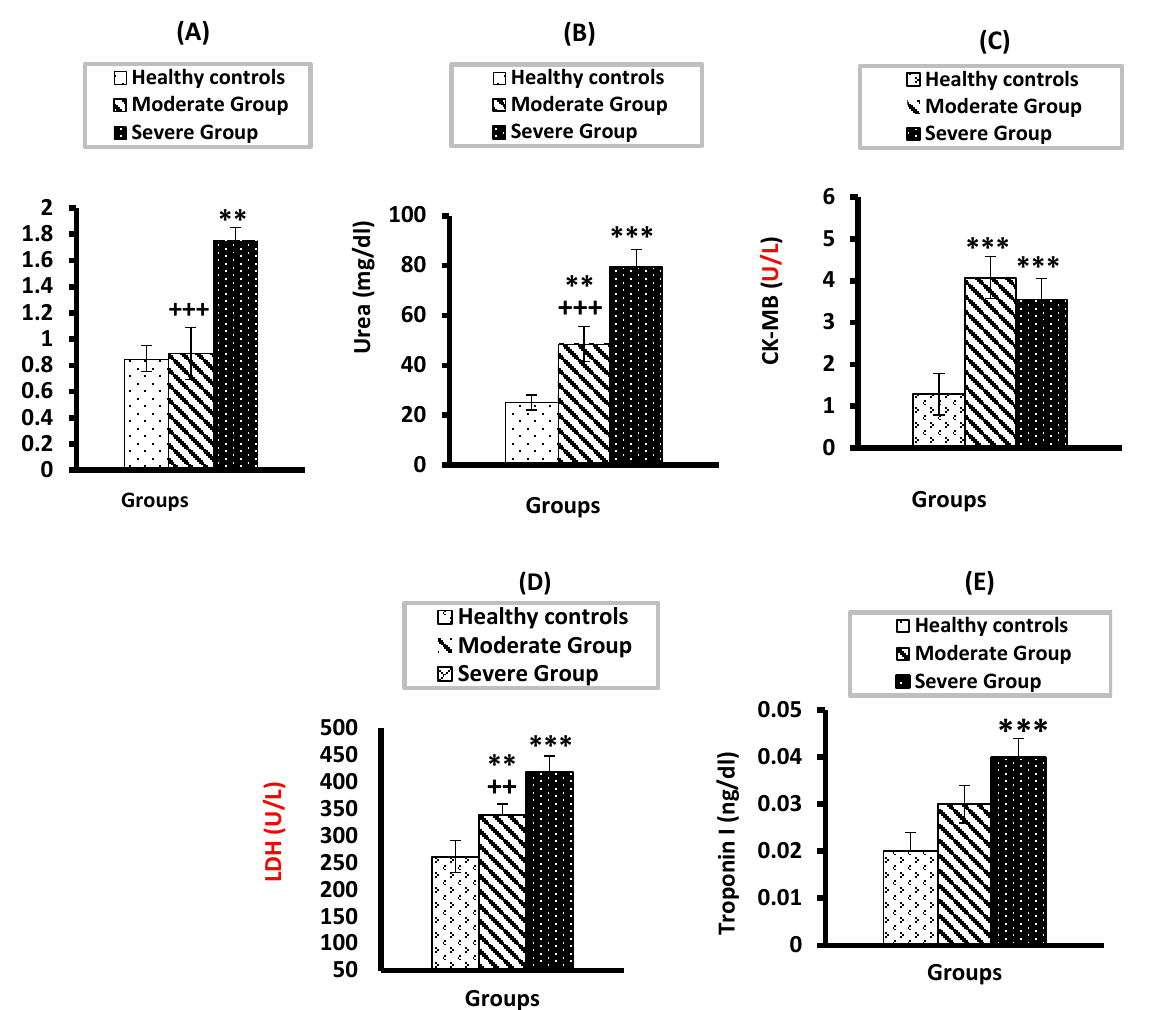
Figure 1. Serum levels of creatinine ( A ), urea ( B ), CK-MB ( C ), LDH ( D ), and Troponin ( E ) in moderate and severe COVID-19 groups compared to healthy control. ** and *** significant compared to heathy control at p < 0.01 and p < 0.001, respectively; +++ significant compared to severe group at p < 0.001; ++ significant compared to severe group at p < 0.01.